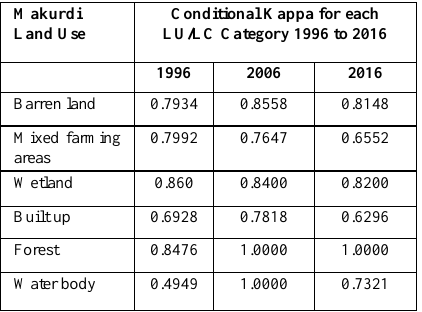
Table 3. Results of accuracy assessment of classified images.